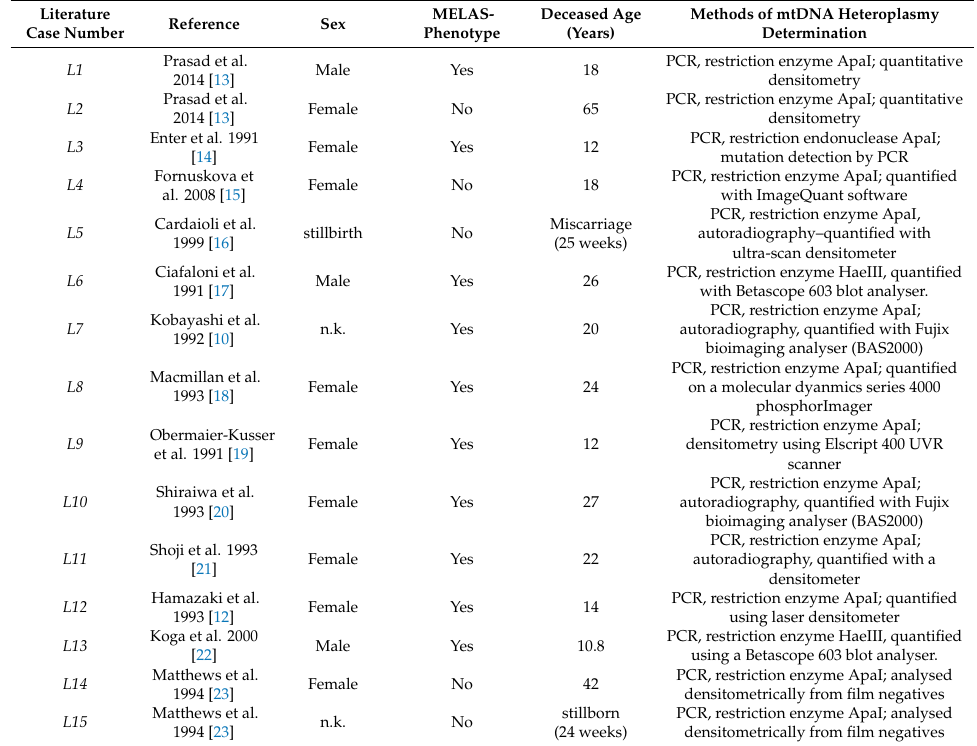
Table 1. Details of the literature cases included in this study, including sex, clinical information and methods of mitochondrial DNA (mtDNA) heteroplasmy determination; n.k. = not